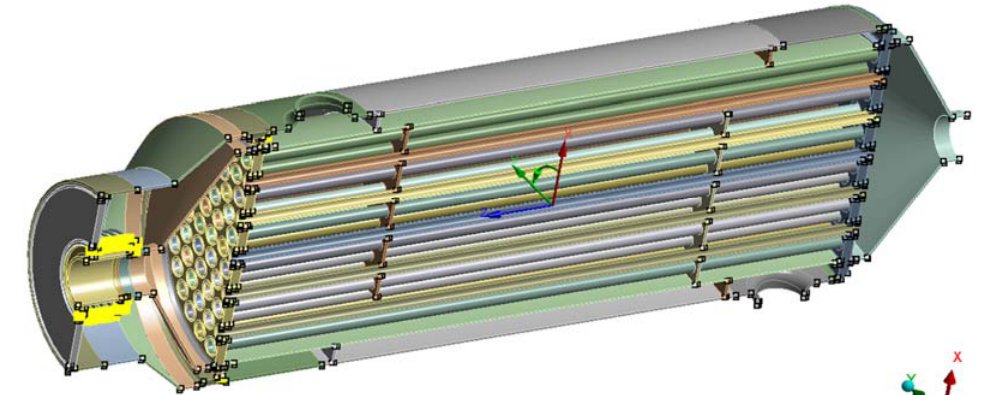
Figure 1: Structural model of HE